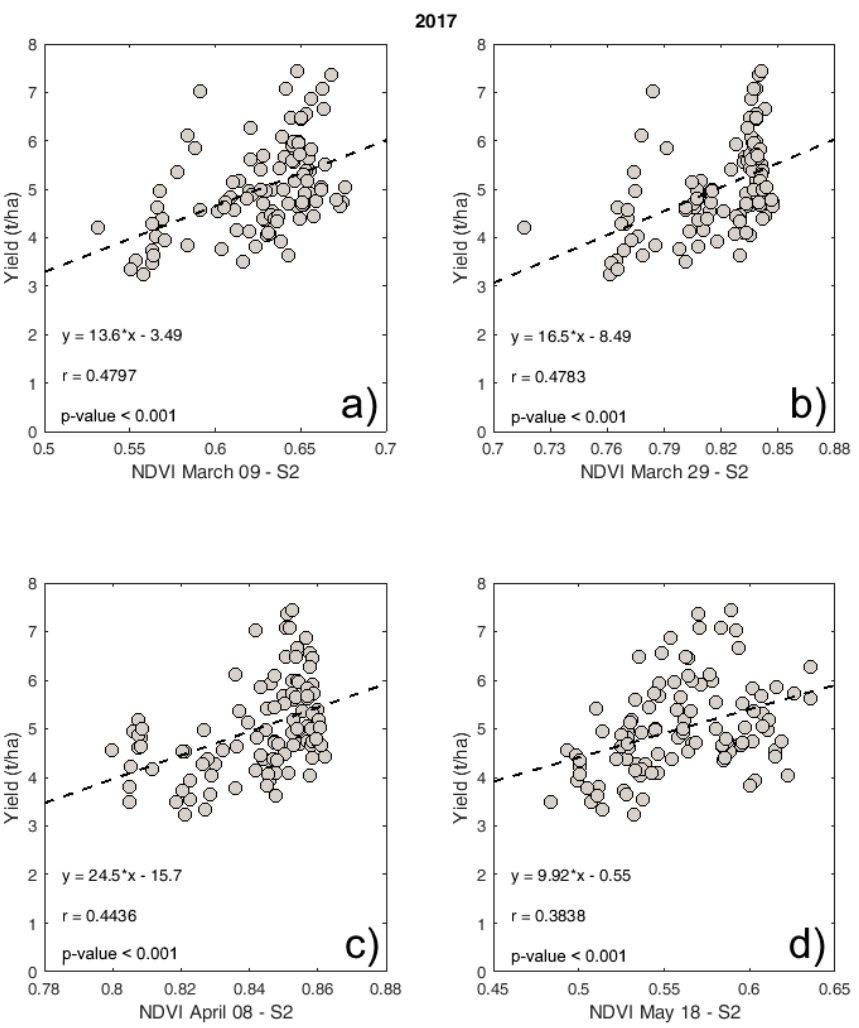
Figure 10. Relationship between observed yield (sampled) and NDVI (Sentinel-2) for 2016–2017 crop season in ( a ) 9 March, ( b ) 29 March, ( c ) 8 April and ( d ) 18 May.